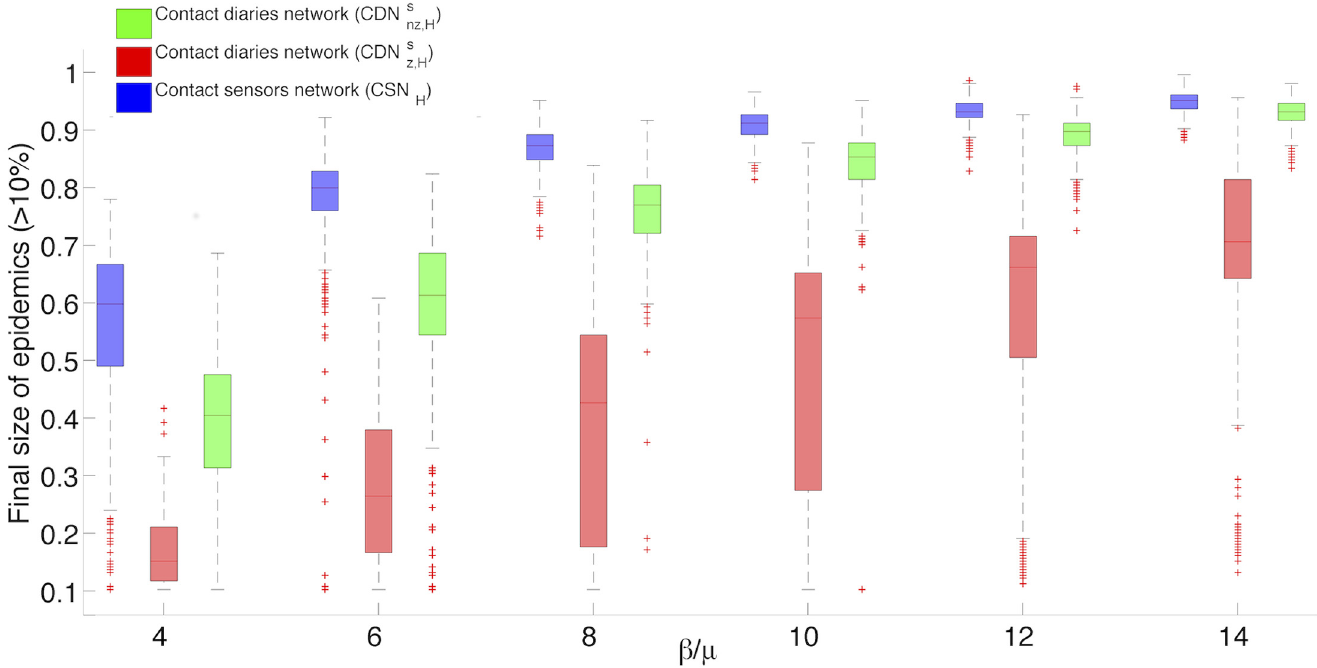
Fig 4. Box-plots of epidemic size distributions. Comparison of the distributions of epidemic sizes for epidemics reaching more than 10% of the population, resulting from SIR simulations performed on the contact sensors network with homogeneous weights (CSN H ) and two surrogate contact , CDN s ). For each boxplot, the central mark stands for the median, its edges represent the 25 th diaries networks with homogeneous durations (CDN s z ; H nz ; H and 75 th percentiles. The whiskers extend to the most extreme data points not considered outliers, while outliers are plotted individually. Points are drawn as outliers if they are larger than a + h ( b − a ) or smaller than a − h ( b − a ), where a and b are the 25th and 75th percentiles, respectively and h is the maximum whisker length set by default to h = 1.5. (1000 simulations for each value of the ratio β / μ 2 {4, 6, 8, 10, 12, 14}).